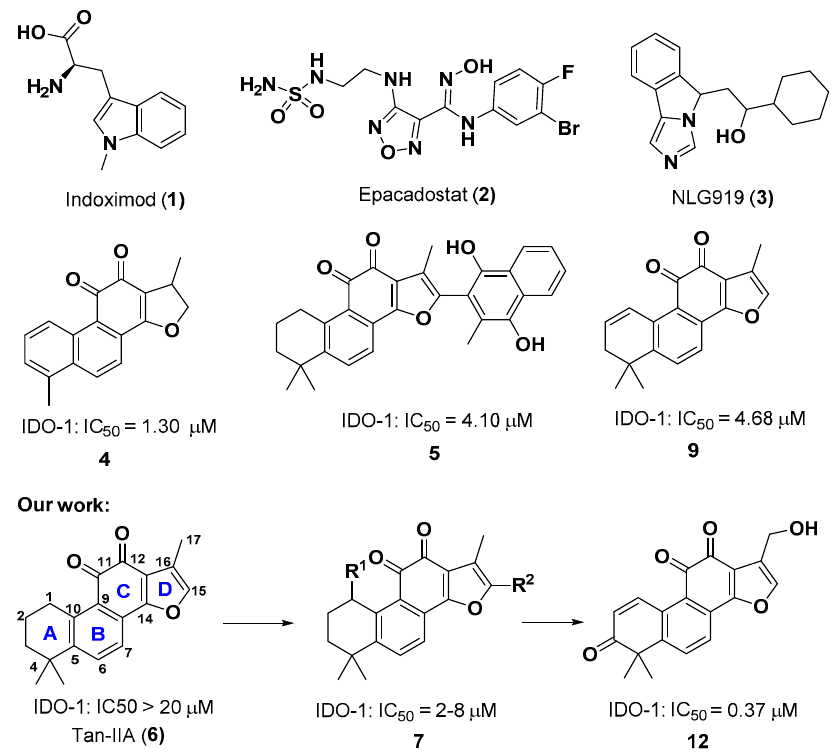
Figure 1. Structures of known and our reported indoleamine 2,3-dioxygenase 1 (IDO-1) Inhibitors.